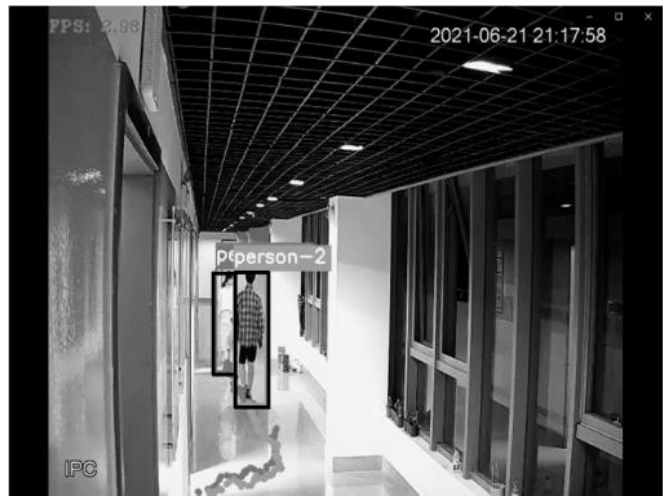
Figure 3. Visual target tracking results.